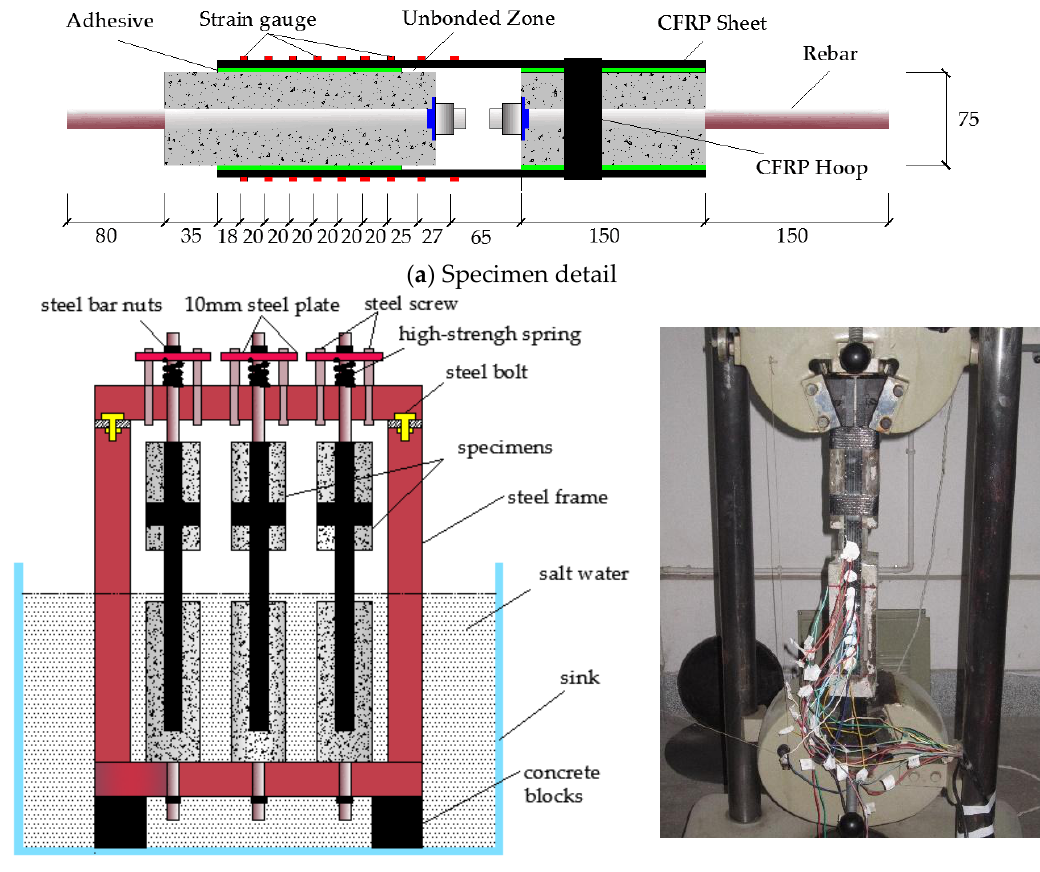
Figure 1. Details of specimens and apparatus.